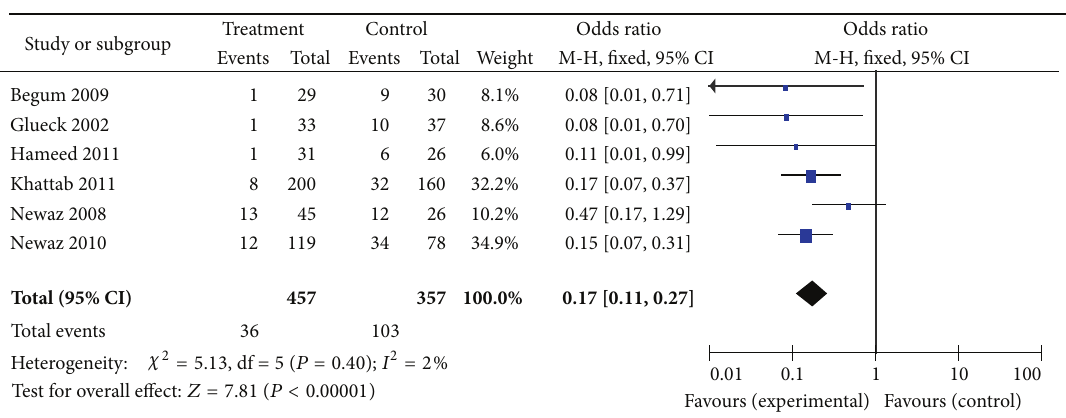
necessity of metformin use in pregnancy considering the background incidence of diabetes in the confounder of the underlying diseases with PCOS that have been linked to increased rates of